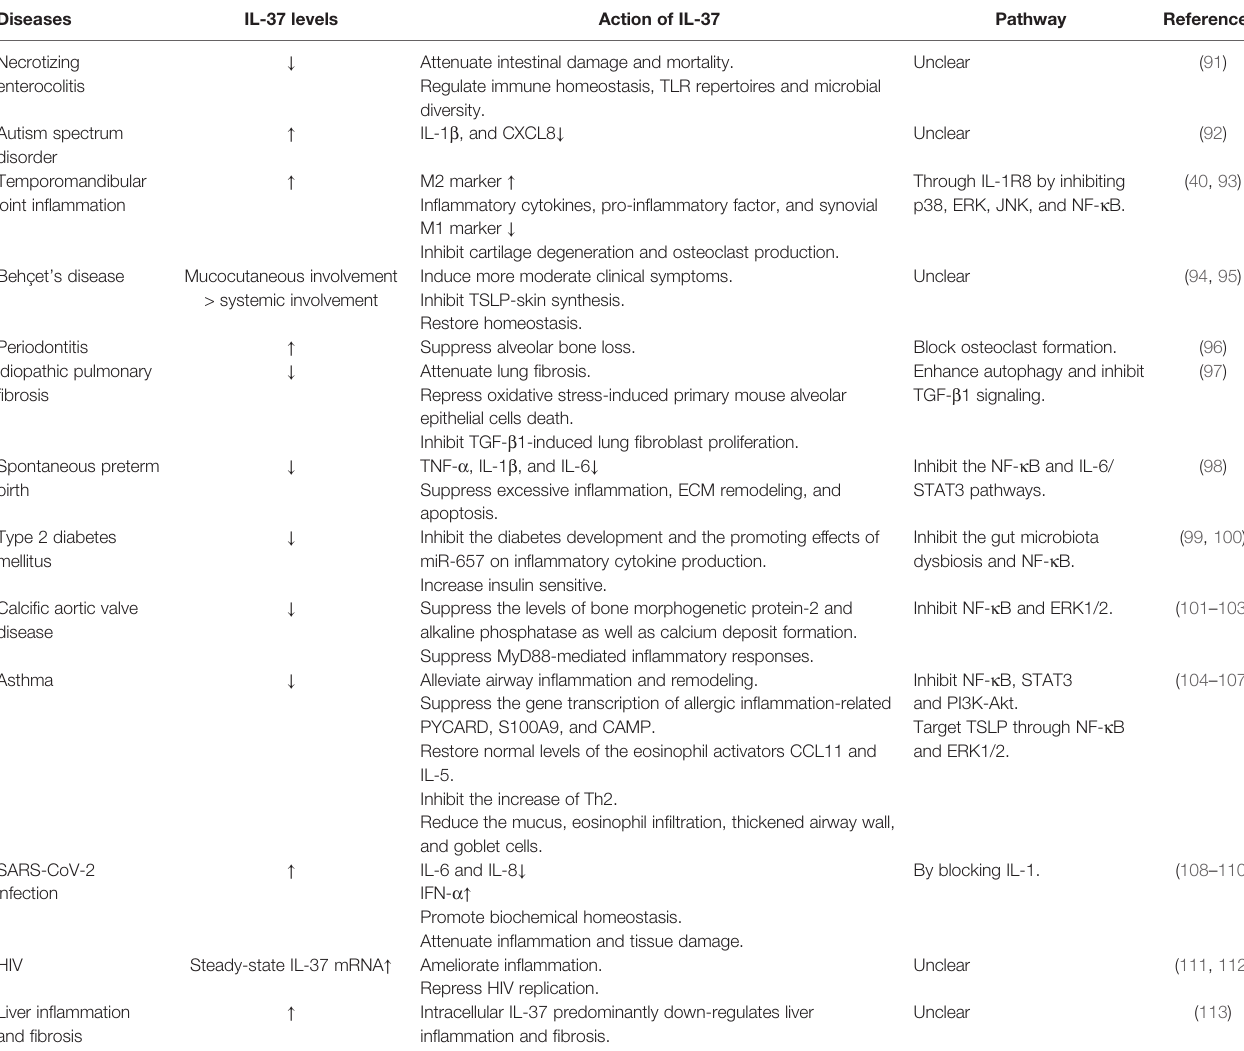
TABLE 1 | IL-37 alternation in diseases and result of IL-37